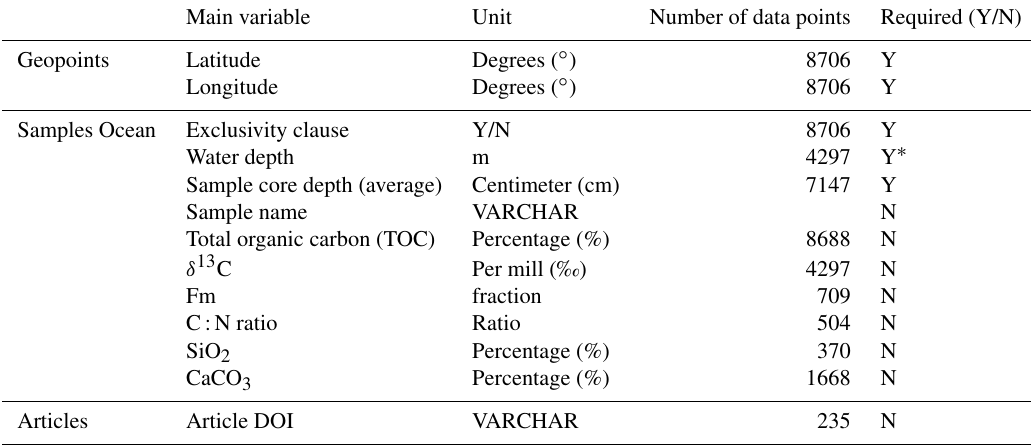
Table 1. Overview of key variables and their abundance in the MOSAIC database. An exhaustive list can be found in the Supplement. Main variable Unit Number of data points